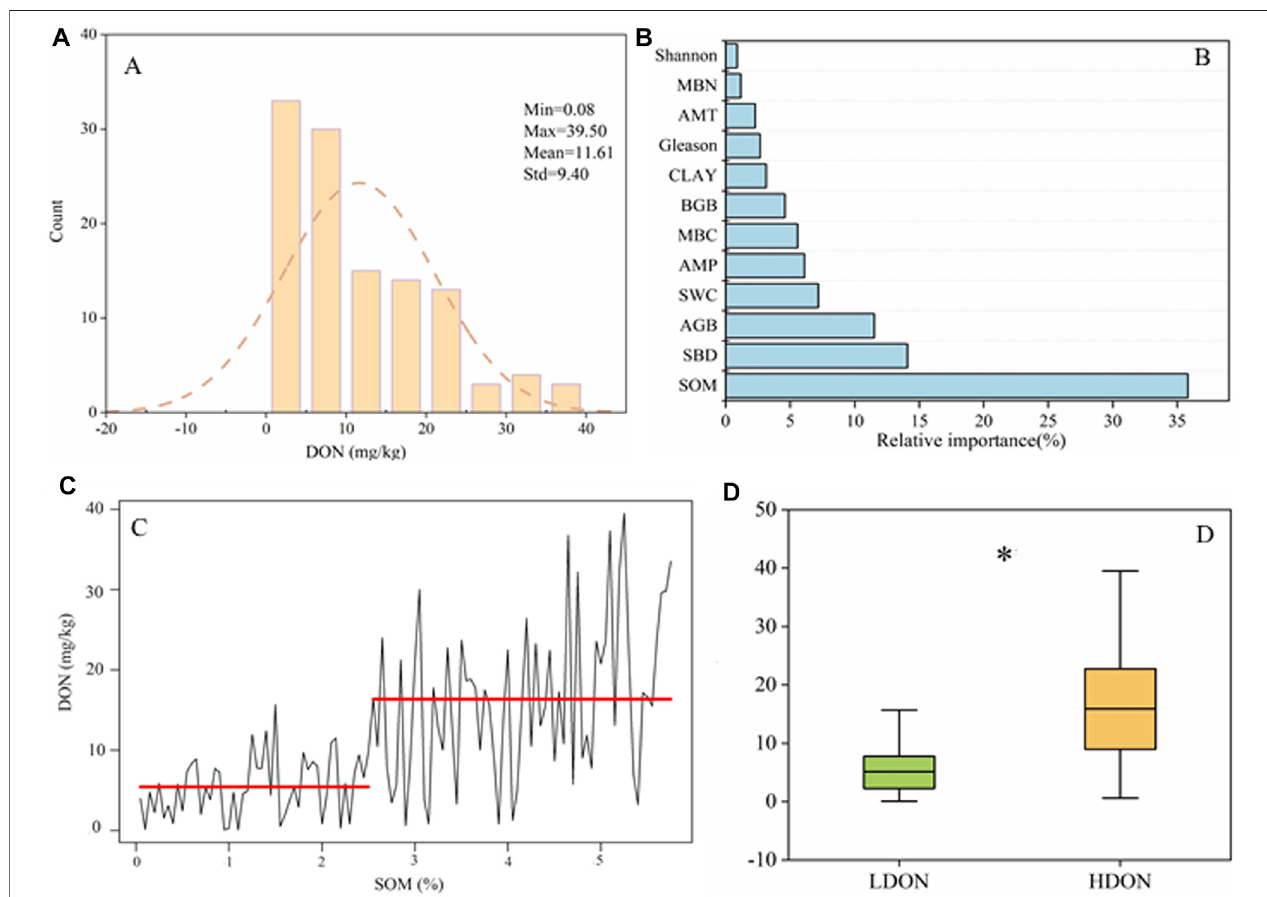
FIGURE1| Frequencydistributionsofthedissolvedorganicnitrogen(DON): (A) relativeimportanceofenvironmentalandbiologicalfactorsexplainingDON, (B) the changepoints ofDON along soil organic matter (SOM), (C) change indissolveorganic nitrogen in different patterns, and (D) “ * ” indicates signi fi cant differences between different